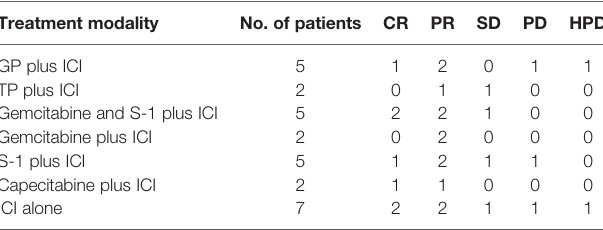
TABLE 1 | Detailed treatment and response information for the current study.